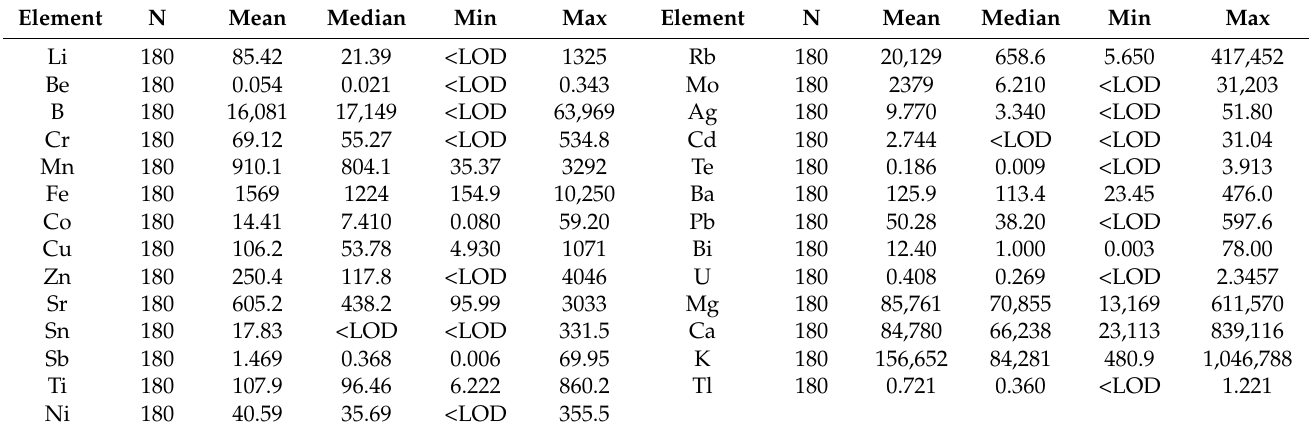
Table 5. Basic statistics for determined elements for all wine samples ( n = 180) [ µ